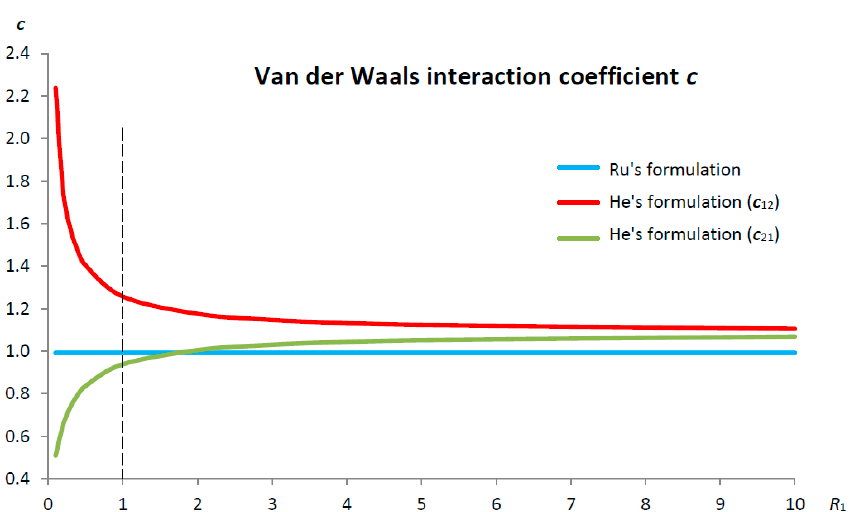
Figure 3. Effect of the inner radius R 1 (10 − 9 m) on the value of van der Waals interaction coefficient c (10 20 N/m 3 ) of the DWCNT of Table 1. Comparison between Ru’s (38) and He’s (39) formulations.